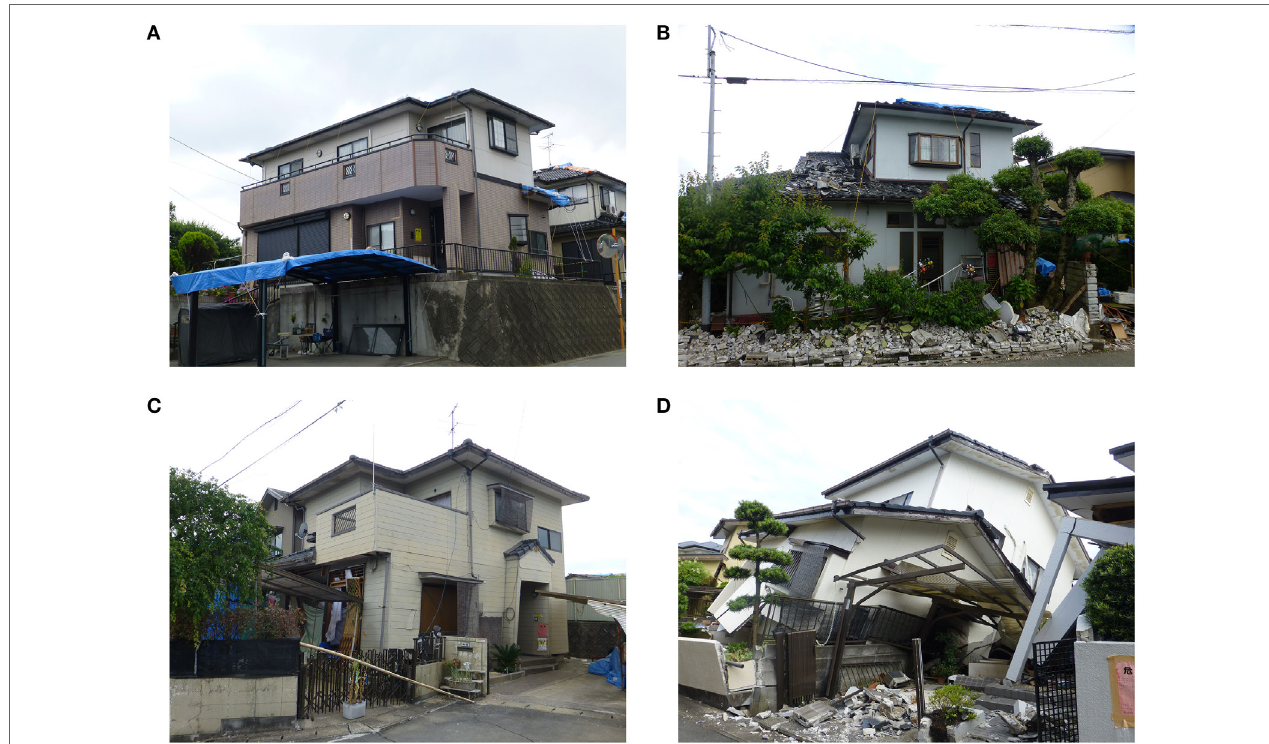
FigUre 14 | examples of damaged and collapsed timber buildings in Mashiki Town: (a) slight damage, (B) moderate damage, (c) heavy damage, and (D) collapse